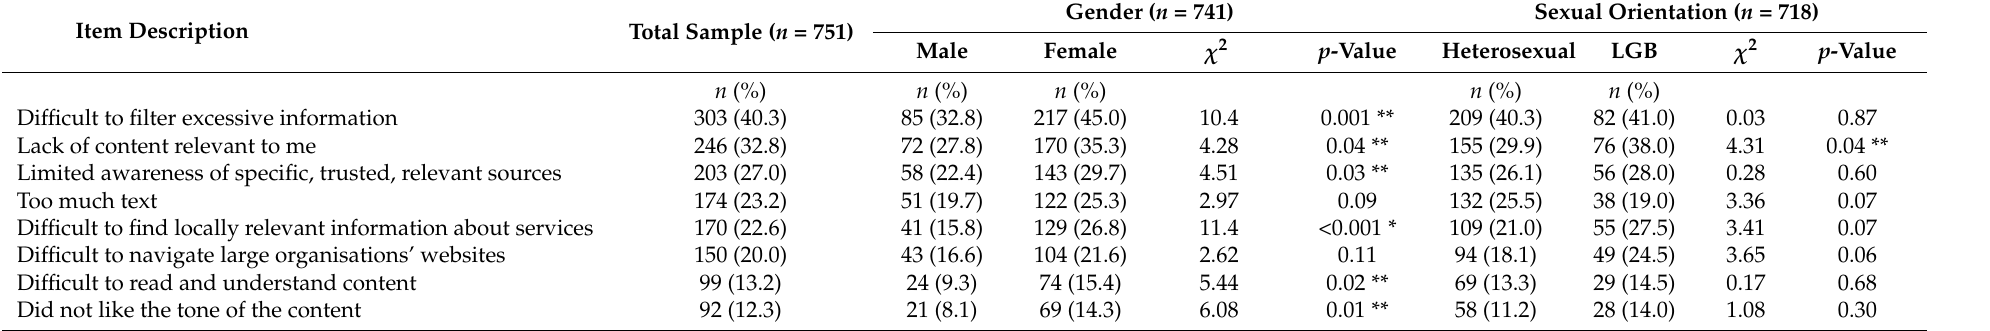
Table 5. Frequencies of practical difficulties experienced when accessing online sexual health information, accounted for by gender and sexual